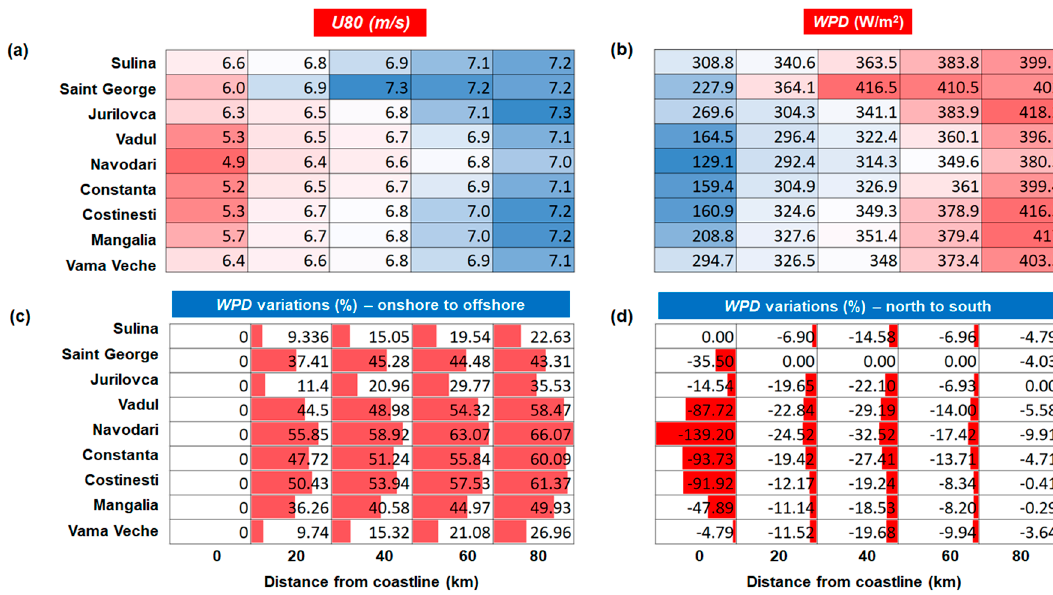
Figure 4. The spatial distribution of the wind parameters, considering the ERA-Interim data for the time interval from January 1998 to December 2017. The results are indicated for: ( a ) U 80 parameter-average values; ( b ) WPD parameter-average values; ( c ) WPD variations-onshore to offshore; ( d ) WPD variations-north to south, considering the maximum value (per each column) as a reference.